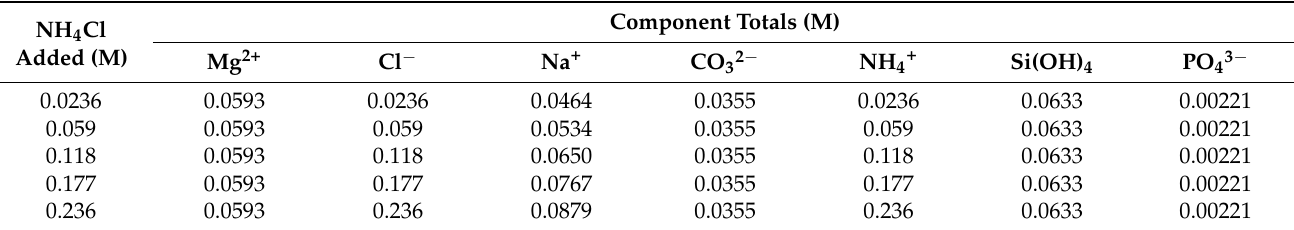
Table A4. MINEQL+ component totals for Mg silicate at pH 9.